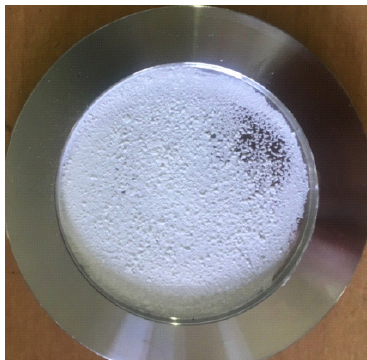
Figure 1. Experimental diagram for the constant volume method. ① Reserve tank; ② thermostat bath; ③ reactor; ④ thermocouple; ⑤ pressure gauge; ⑥ thermostatic chamber; ⑦ vacuum pump; ⑧ valve; ⑨ evaporator; ⑩ water tank.